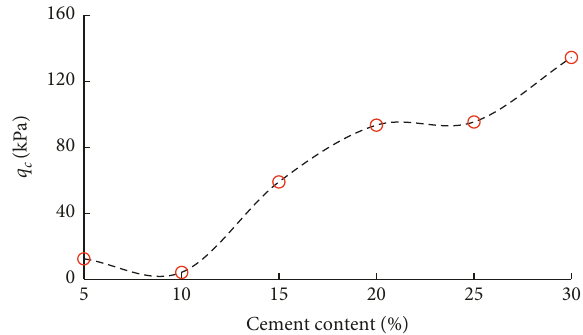
Figure 15: Failure strain ε u of slurry with various cement contents.